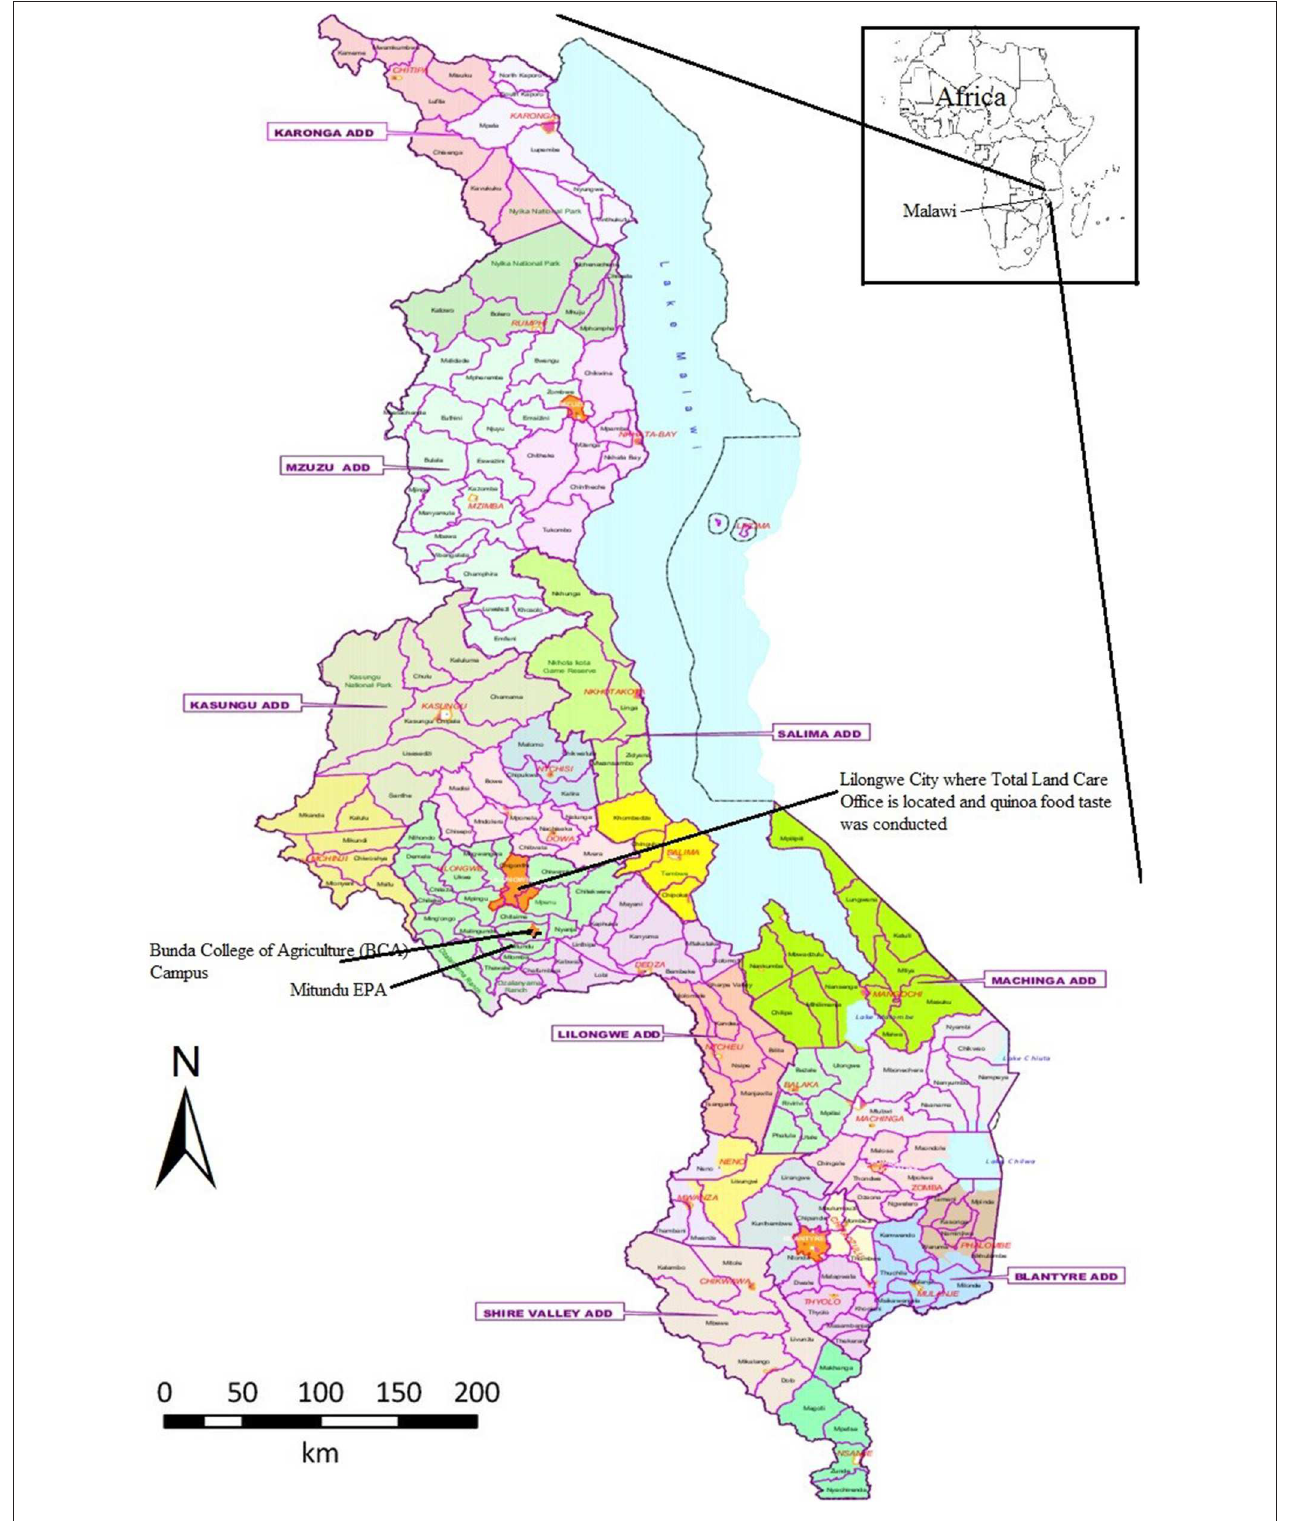
FIGURE 1 | Map of Malawi showing the location of the quinoa food taste test, the Bunda College of Agriculture campus, and Mitundu EPA.